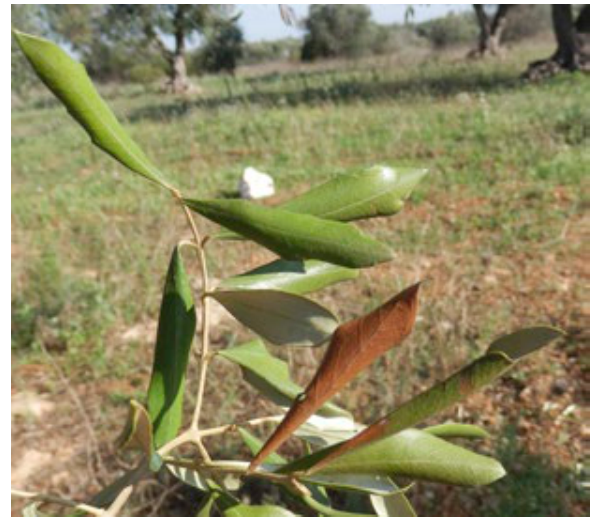
Figure 2. Symptoms of the quick decline syndrome on 1-year-old twigs of olive plants in Taviano (Lecce, South Italy). Dull green leaves were sampled for Xylella fastidiosa DNA